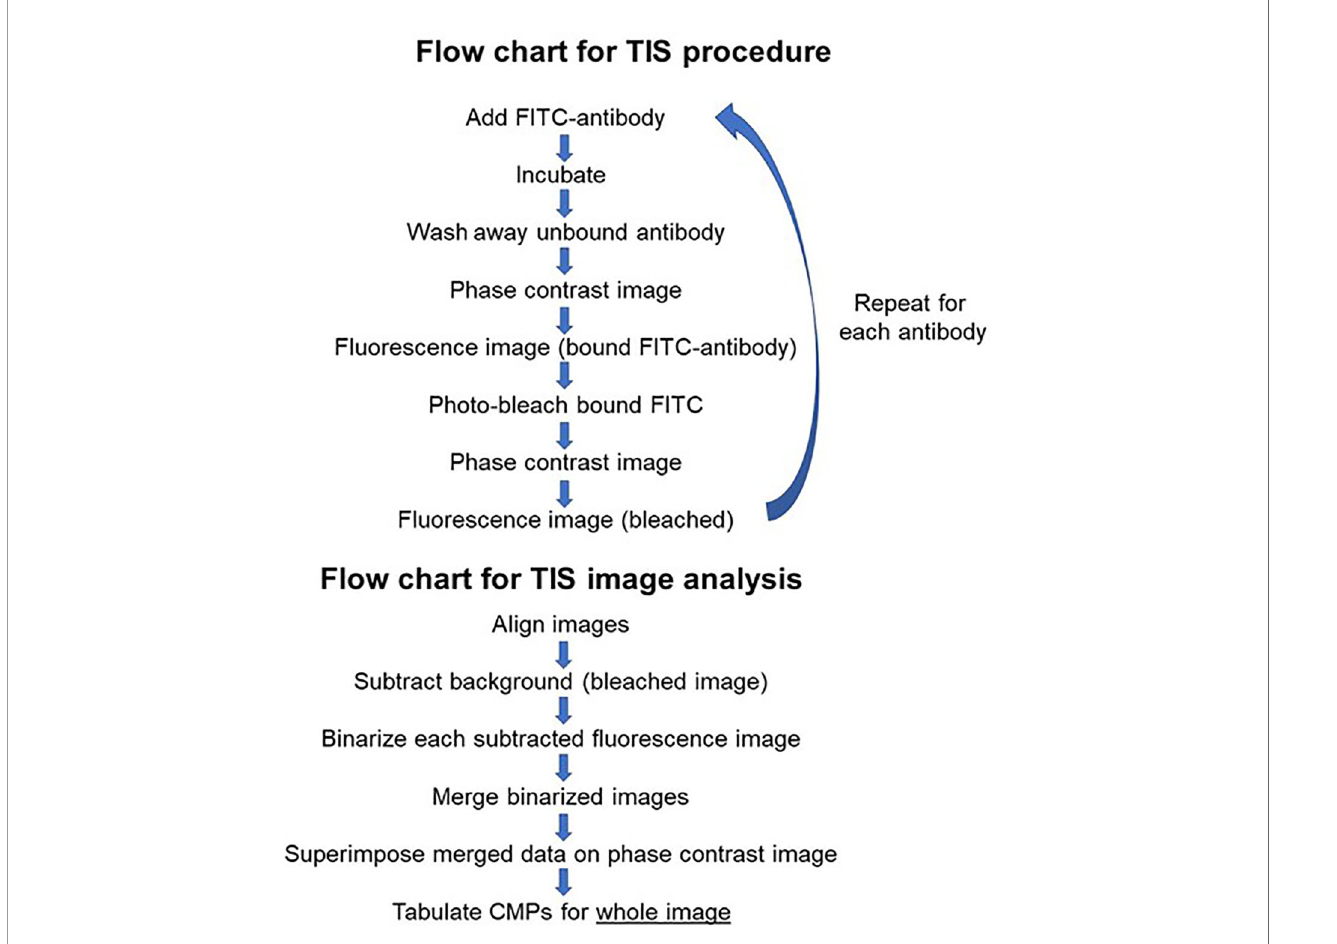
FIGURE 2 | Flow chart. Figure 2 is fl ow chart that describes the TIS procedure and the steps involved in the analysis of images generated by